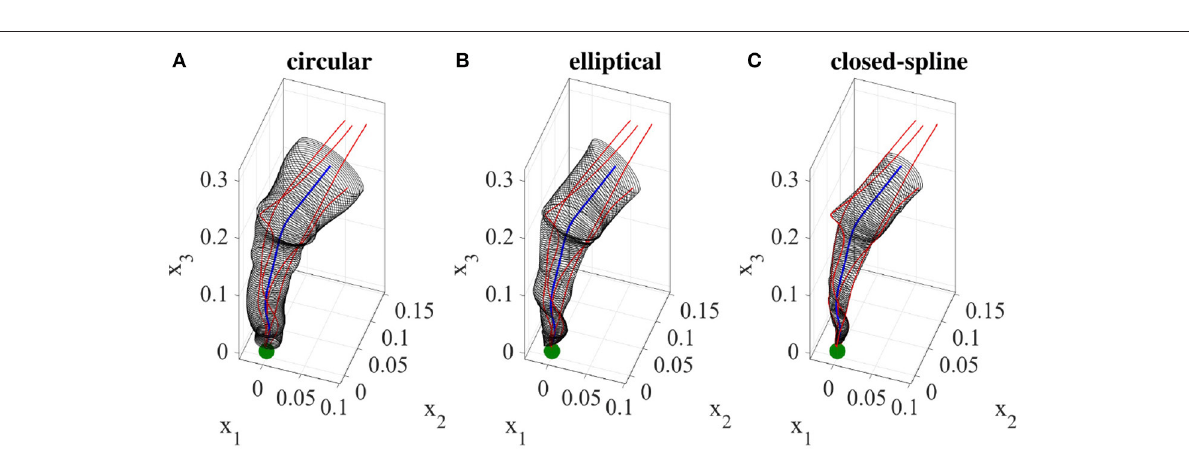
F 1 T ´ p F 0 p 0 and then similar to the previous step, we find 1 = g 1 , the intersection of the ray started from c 1 passing through ´ p 1 .